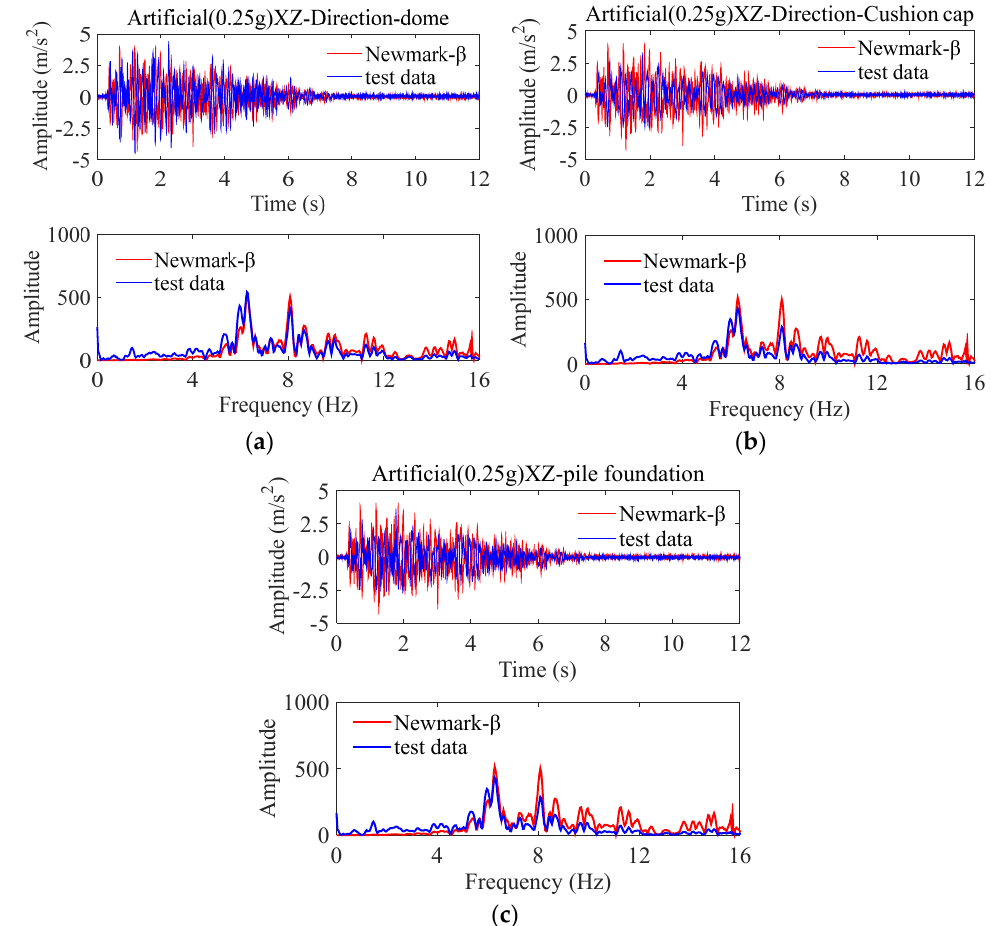
Figure 16. Comparison of shaking table test data and theoretical solutions under the artificial wave: ( a ) dome acceleration time history and spectrum comparison; ( b ) cushion cap acceleration time history and spectrum comparison; ( c ) pile foundation acceleration time history and spectrum comparison.